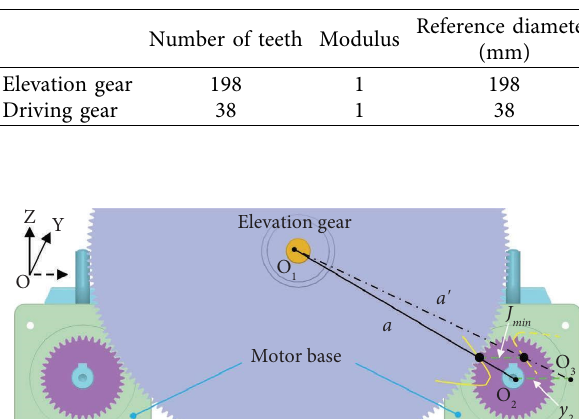
Table 2: Te parameters of the two